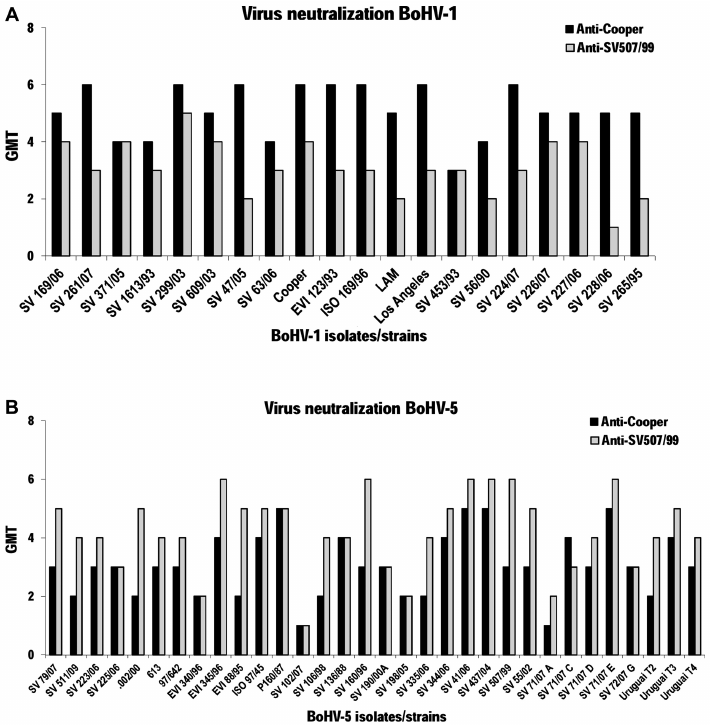
Figure 3. Virus neutralization geometrical mean titers (GMT) of 20 isolates/strains of bovine herpesvirus 1 (BoHV-1) against homologous (Cooper strain) and heterologous (SV507/99 strain) antisera are demonstrated ( A ). B , GMT of 32 BoHV-5 isolates/strains against homolo- gous (SV507/99) and heterologous (Cooper)